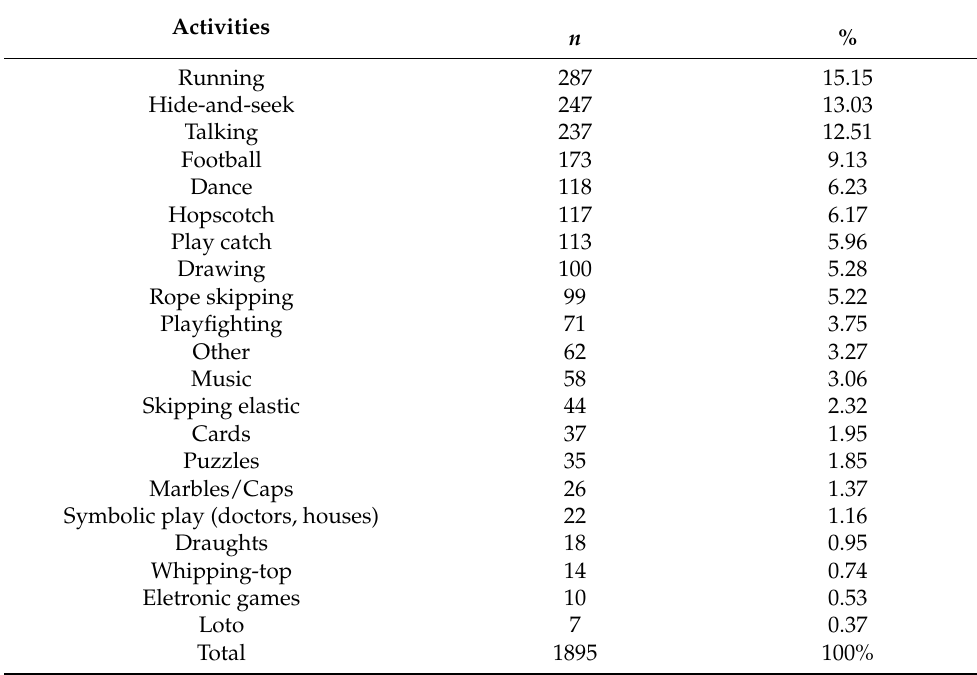
Table A6. Activities carried out by children in primary schools’ recess in the